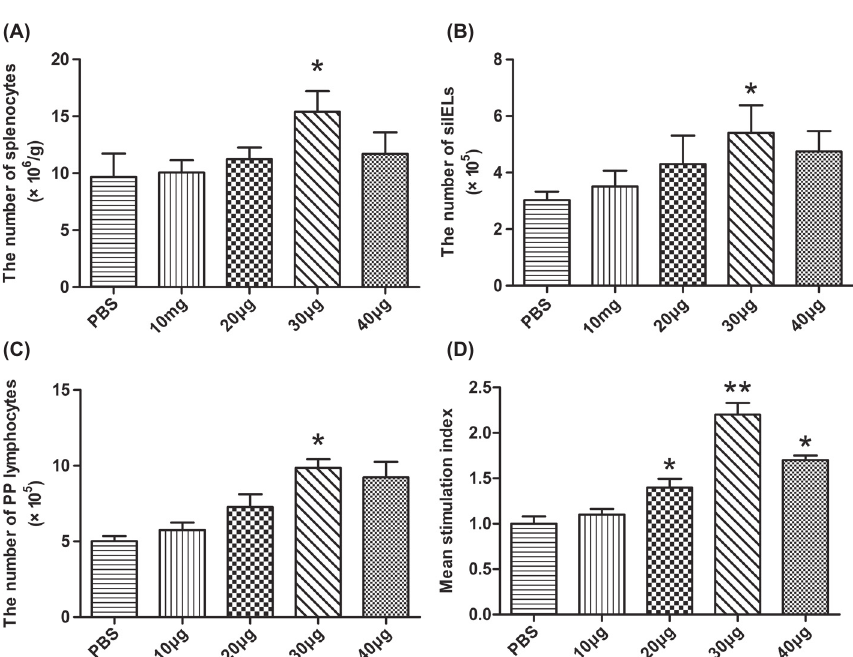
Figure 3. Lymphocyte proliferation responses of immunised mice. Two weeks after the last immunisation with rTgPGAM 2 or PBS, splenocytes, siIELs and PP lymphocytes were prepared and counted in a haemocytometer (A, B and C). In addition, splenocytes were cultured with ConA or rTgPGAM 2 and splenocyte proliferation (D) was measured with a CCK-8 assay. The splenocyte proliferation results are expressed as the mean stimulation index (SI) ± SD ( n = 10) and are representative of three experiments. * P < 0.05, ** P < 0.01 (vaccinated vs. PBS group).